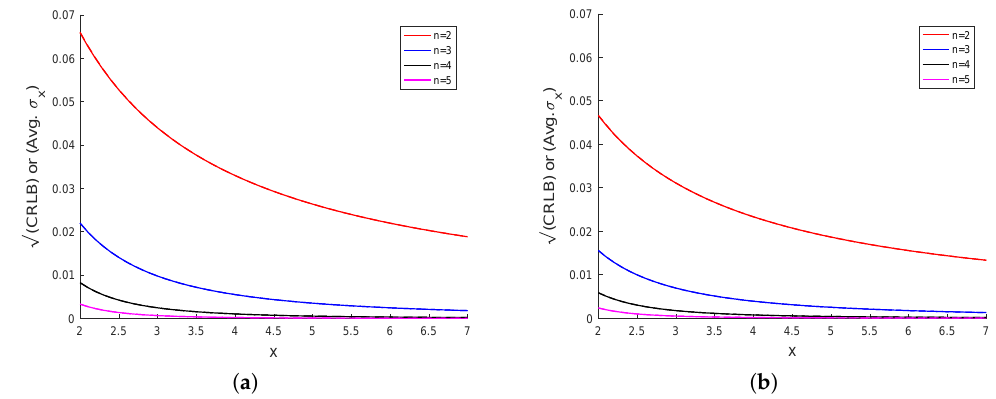
√ Figure 4. ( a ) CRLB or (Avg. σ x ) vs. x using 10 scalar measurements and ( b ) x using 20 scalar